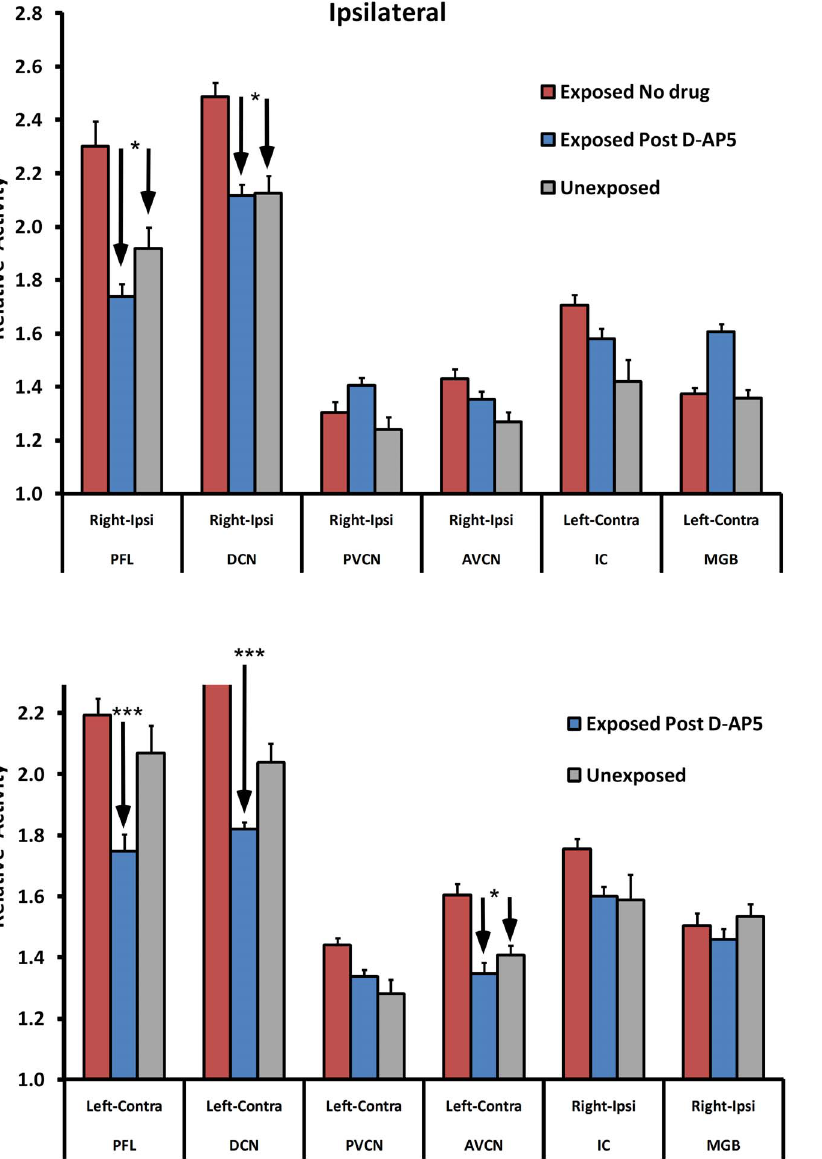
Figure 5. Post D-AP5 spontaneous neural activity indicated by manganese enhanced magnetic resonance imaging (MEMRI). Depicted are normalized data (AOI / adjacent muscle area). Elevation was evident in the ipsilateral paraflocculus (PFL) and dorsal cochlear nucleus (DCN) of Exposed untreated, but not in Exposed D-AP5 treated animals, in comparison to Unexposed controls (top panel). Contralateral elevation (bottom panel) was evident in the PFL, DCN, and the anterior ventral cochlear nuclei (AVCN). Posterior ventral cochlear nucleus (PVCN), inferior colliculus (IC), medial geniculate body (MGB). Error bars indicate mean deviation (*** p , 0.0001; * p , 0.05); statistical summary in Table 2.